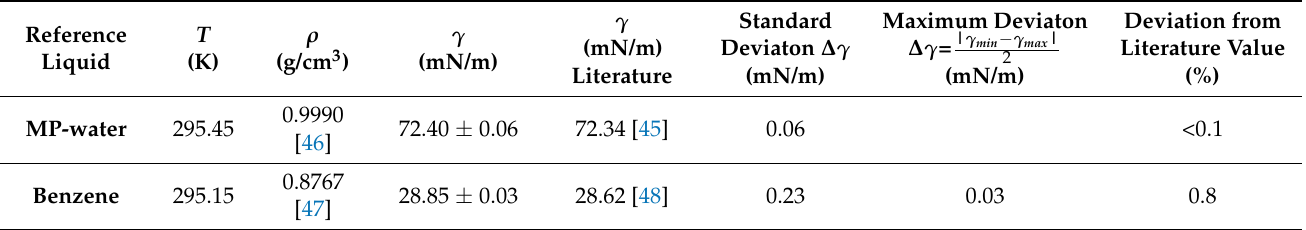
Table 1. Surface tension reference measurements with water and benzene at room temperature and atmospheric pressure (p ≈ 1 bar). Density and literature surface tension for water are from Refs. [45,46] and for benzene from Refs. [47,48]. The maximum error in the surface tension compared to the literature values is 0.1% for water and 0.8% for